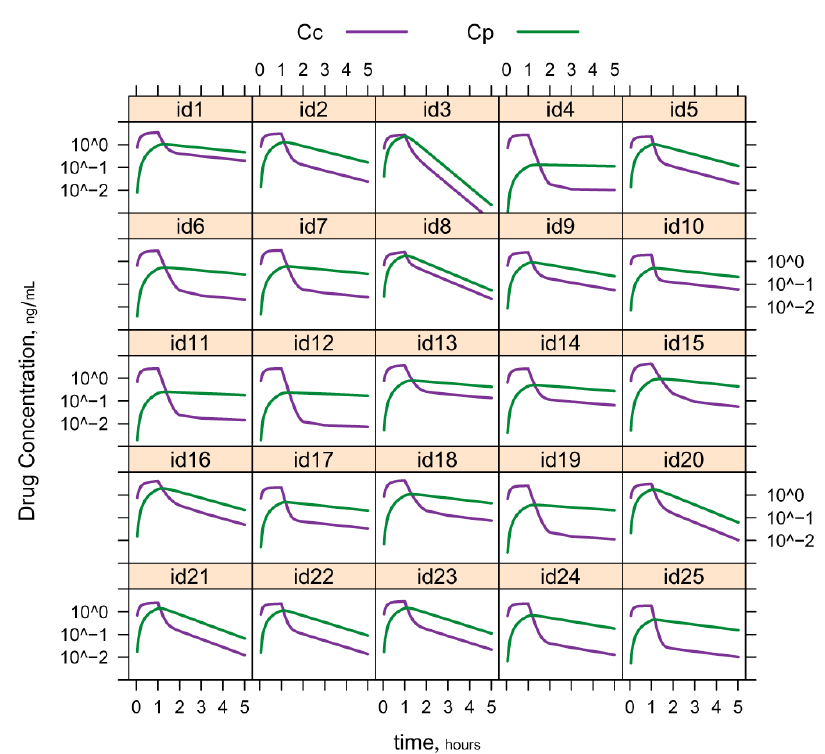
Figure 1. Two-compartment pharmacokinetics of a 1-hour infusion of 100 mg of the modeled drug, for 25 randomly generated individuals in our population pharmacokinetic model. C respectively.